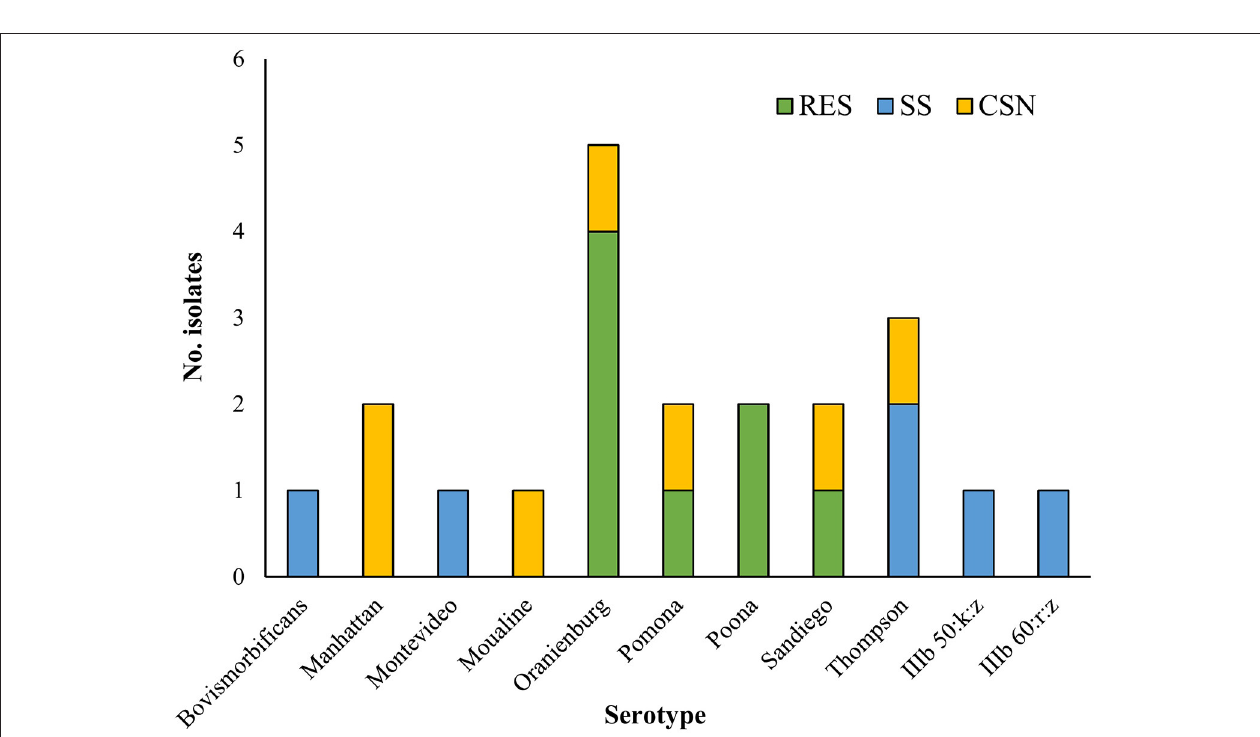
S. IIIb 60:r:z ( Figure 2 ). A list of the S. enterica isolates, including GenBank accession Numbers can be found in Table 2 . All